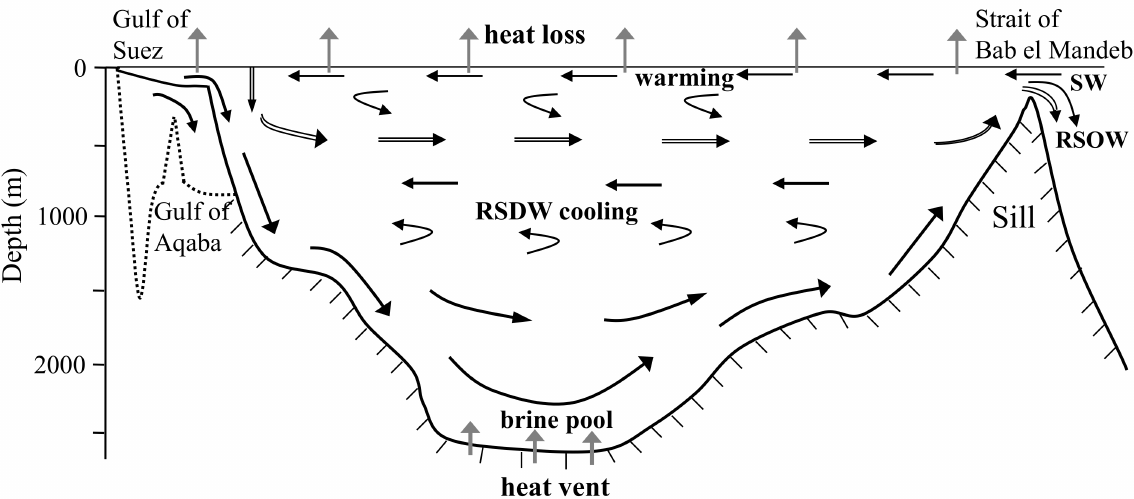
Figure 7. Schematic of the heat transport and circulation patterns in upper layers, upper deep layers, and deep layers in Red Sea. Dotted topography represents Gulf of Aqaba. SW: surface water; RSOW: Red Sea outflow